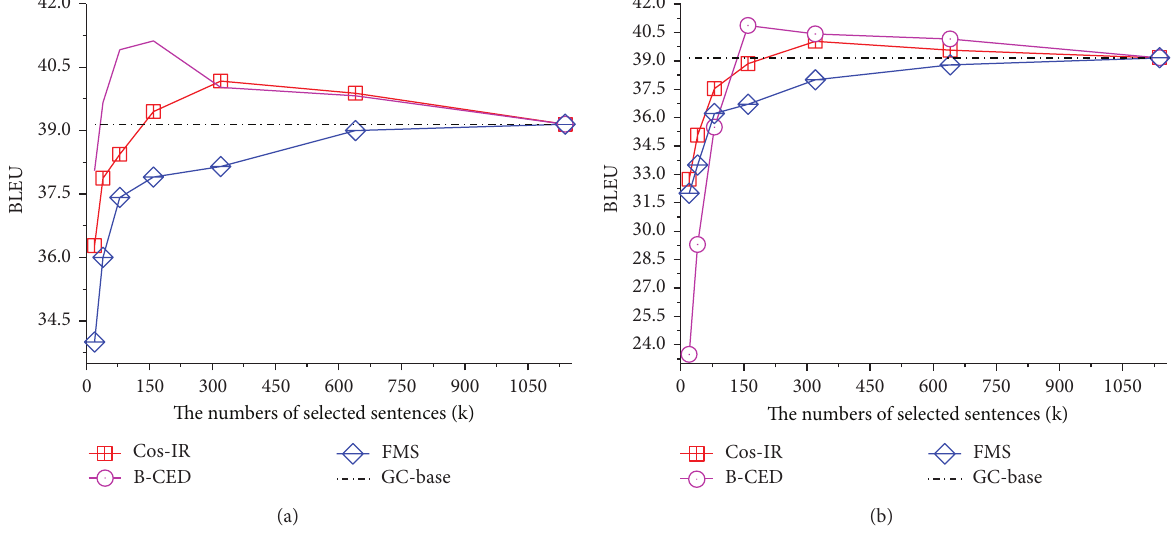
Figure 3: BLEU scores via different data selection methods with dev. (a) and in-domain (b)